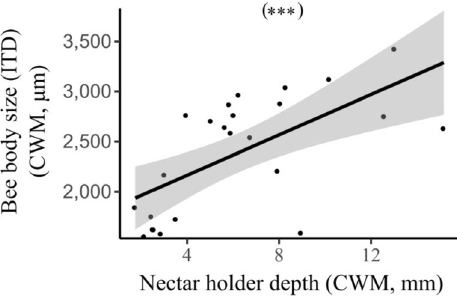
Figure 2. Relationship between community weighted mean of bee intertegular distance (ITD) and community weighted mean (CWM) of flowering plant nectar holder depth. Plotted lines show the predicted relationship and shaded areas indicate the 95% confidence intervals: *** P ≤ 0.001.